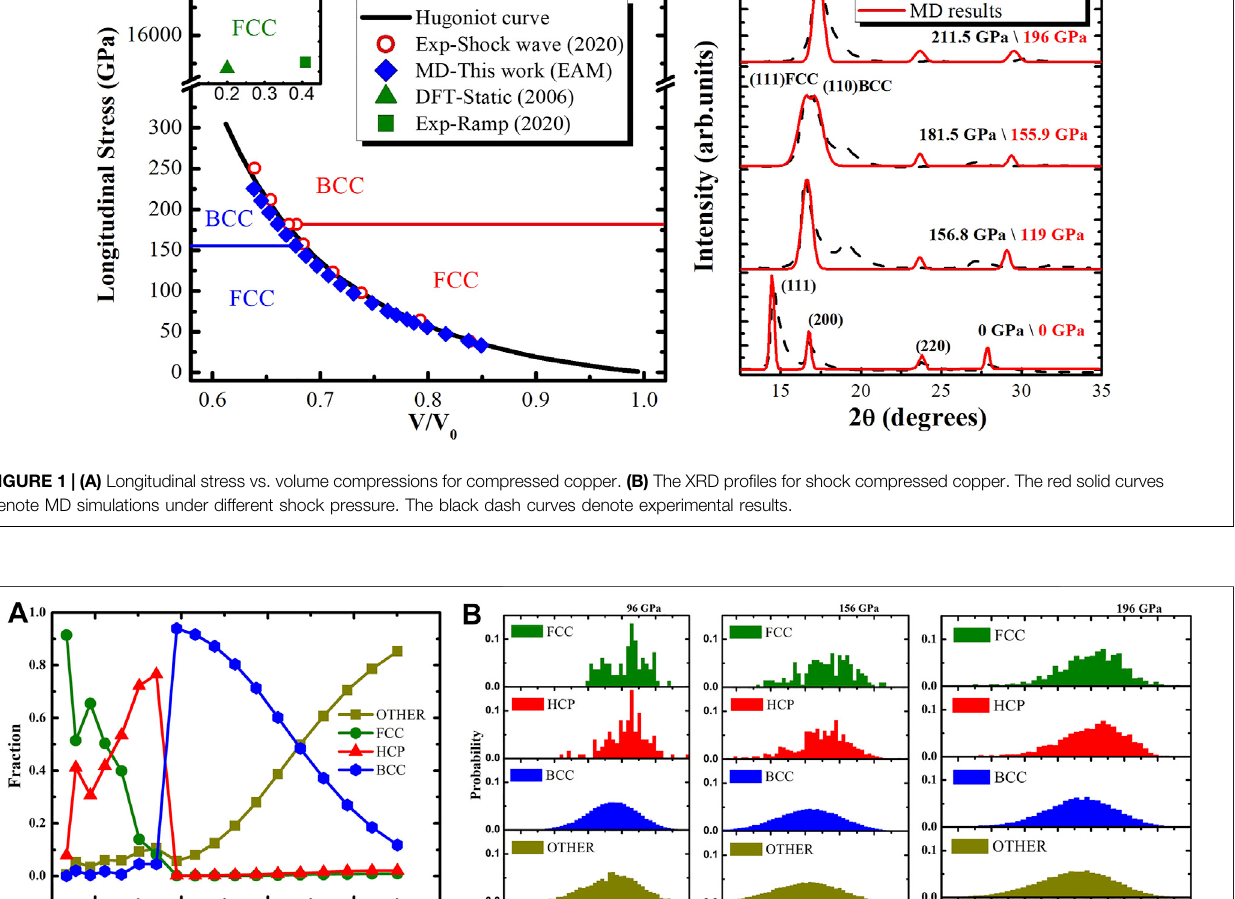
Figure 1A . The results determined from the present simulations coincide with the previously Hugoniot curve and recently shock wave experiment[30]. Based on the XRD measurement, the presence of the BCC structure has been found in lower pressure, as shown in Figure 1B . In the shock experiments, the measured XRD line pro fi les with (hkl) peaks indexed are used to identify the nature of the copper foils. At ambient condition, the MD simulation result is in good agreement with the experimental result. The line pro fi les of the shock experiment show that Cu remains in the FCC phase